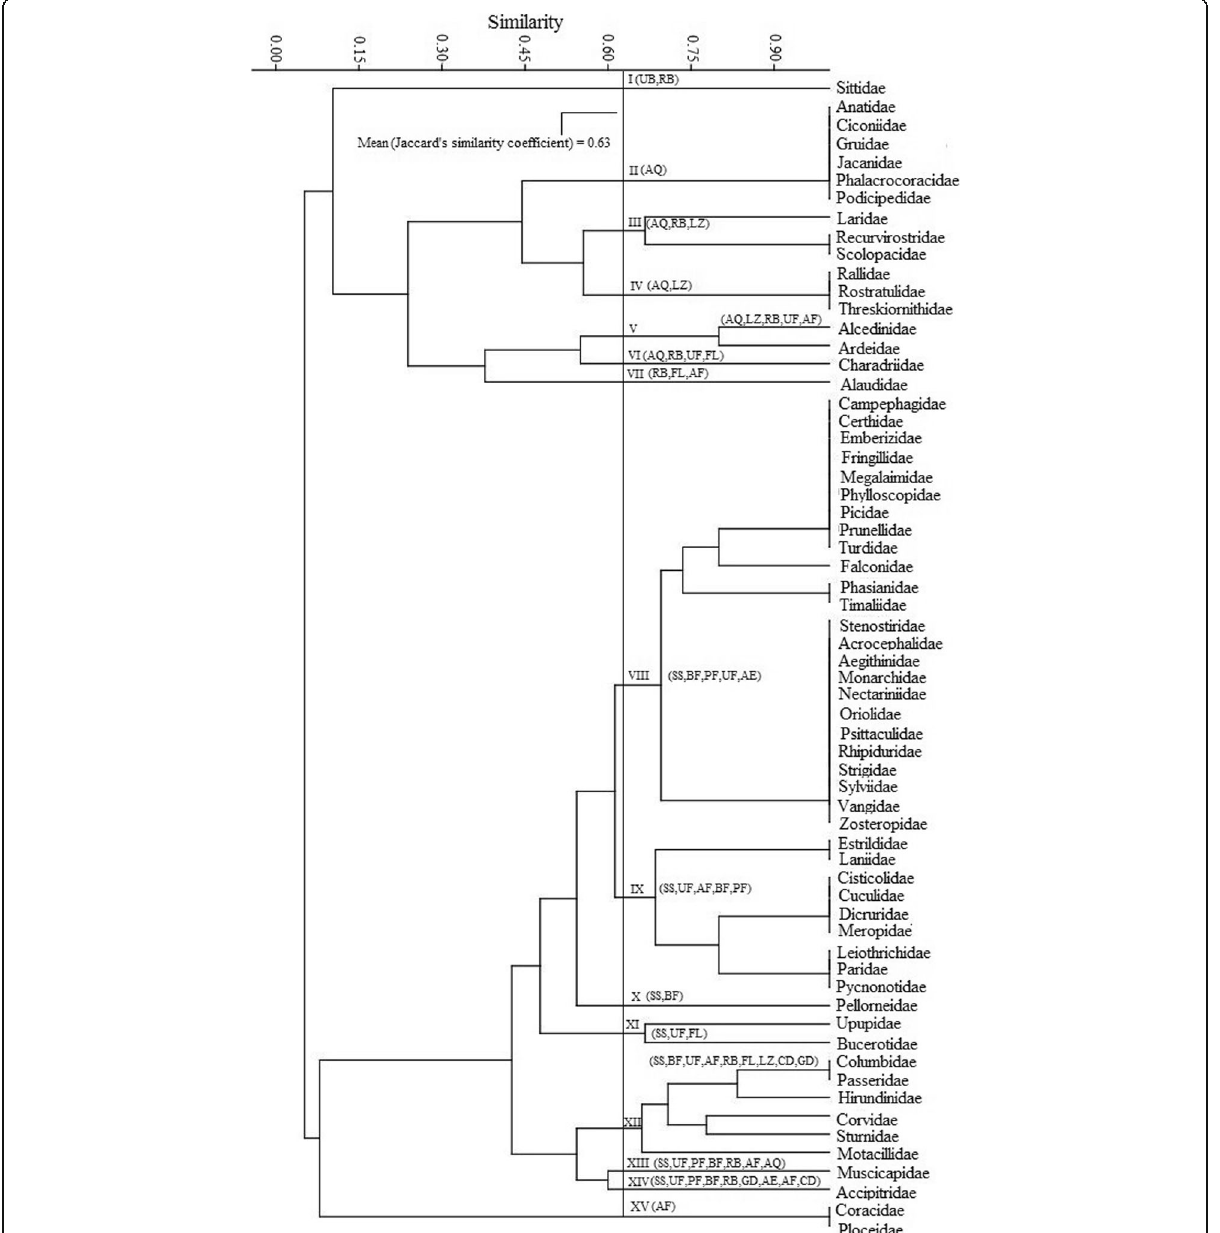
Fig. 8 Jaccard ’ s similarity dendrogram showing habitat guild structure among observed bird families in the study area. Roman numerals refer to guilds and mnemonics in brackets represent the habitat type (see Fig.